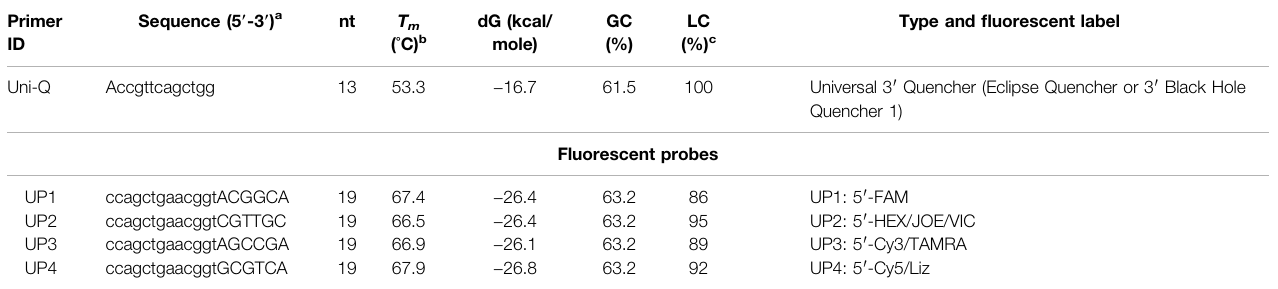
TABLE 3 | Fluorescent probes (UP) and a quencher oligonucleotide (Uni-Q) for Allele-Speci fi c Quantitative PCR (ASQ). Primer